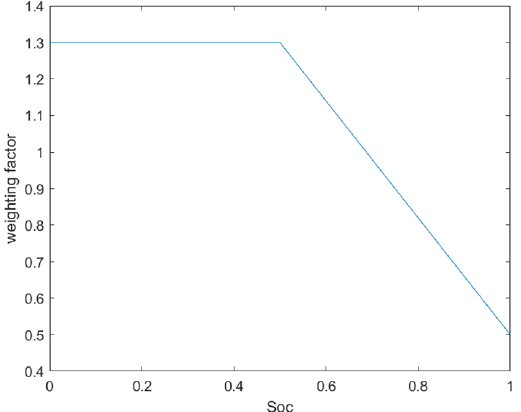
Figure 1. Relationship between the state of charge and weighting coefficient.